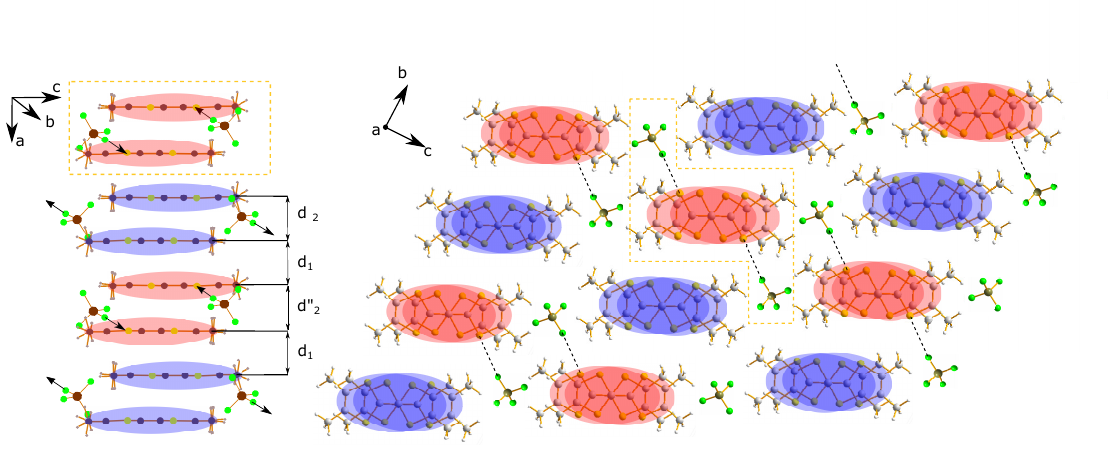
Figure 6. Scheme of the anion arrangement for the tetrahedral (TMTTF) 2 X salts as T < T AO . Upon AO, the anions re-orient in the methyl cavities along the anion-ligand sulfur link in ( − b + c ) -direction, represented by the black dashed line, forming long-range order. Coulomb attraction between the anion-ligand and the charge on the TMTTF molecule results in a 0110 charge pattern; the red and blue ellipsoids mark charge-rich and charge-poor TMTTF molecules, respectively. The polygon formed by the dashed orange line indicates which anion stacks are shown on the left side, illustrating the charge pattern along the stacking direction. In addition to a reorientation of the anions, a shift along the anion-ligand sulfur link occurs as well; this is not included